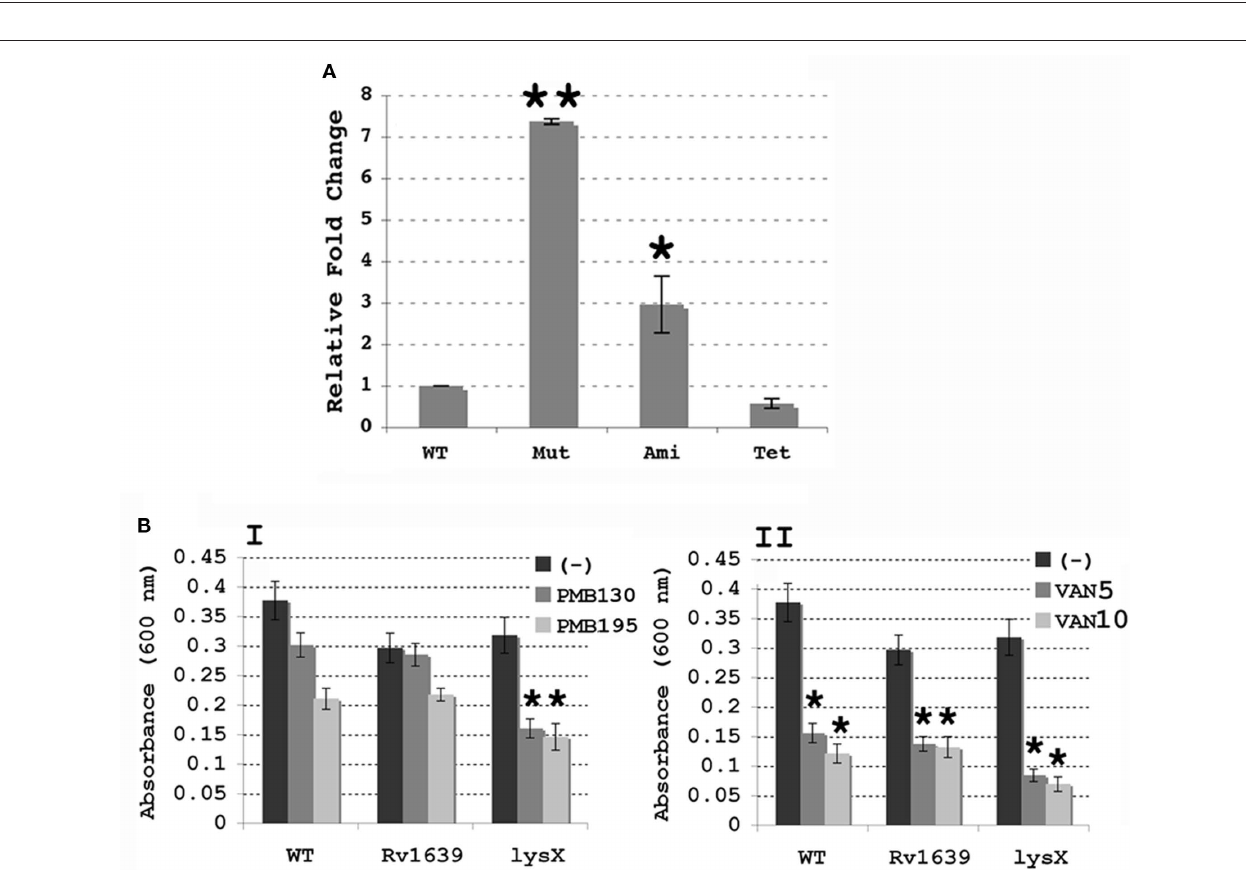
FiguRe 3 | (A) Expression of Rv1639c in M. tuberculosis lys X strains. Expression of Rv1639c was evaluated by real-time PCR using RNA isolated from Wild-type M. tuberculosis (WT), the lys X mutant (Mut) and both the Pami (Ami) and Ptet (Tet) complement strains, and results were normalized against expression of 16s rRNA as described above. All values are the means ± SD from two independent experiments with triplicate samples; single star represents P < 0.01 and double stars indicate P < 0.001 versus WT (Student’s